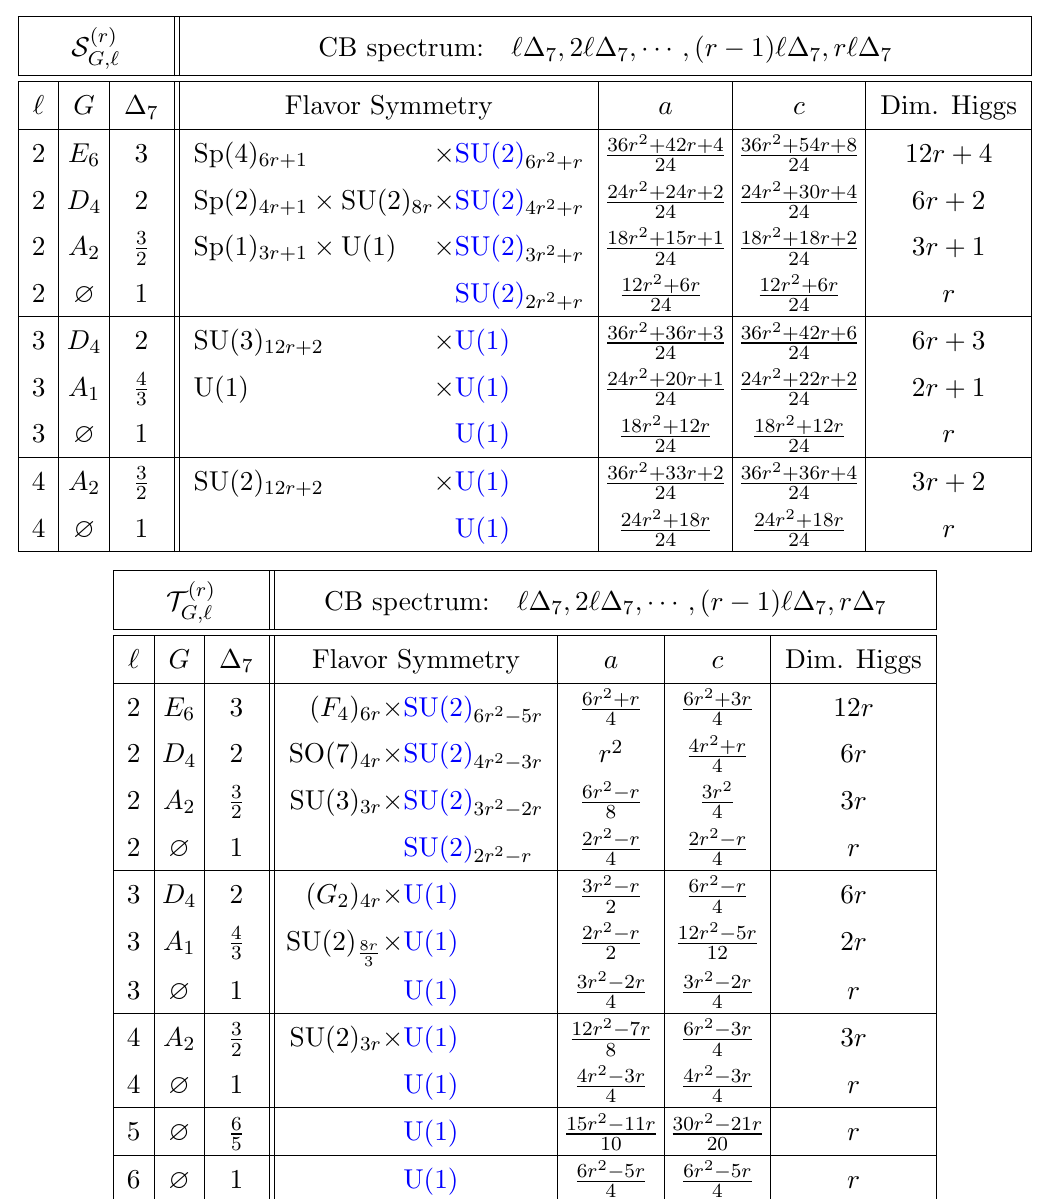
Table 3. Basic properties of theories S ( r ) and T ( r ) . In the (cid:13)avor symmetry, the last factor SU(2) G;‘ G;‘ or U(1), shown in blue, comes from the isometry of C 2 = Z ‘ and the rest comes from the part of G commuting with the asymptotic holonomy. We use subscripts to denote the levels of the (cid:13)avor symmetries. The cases with (cid:1) 7 = 1 have N =4 when ‘ = 2 and N =3 otherwise. The (cid:13)avor symmetries listed here are for generic rank. For the enhancements in low rank, see table 4.